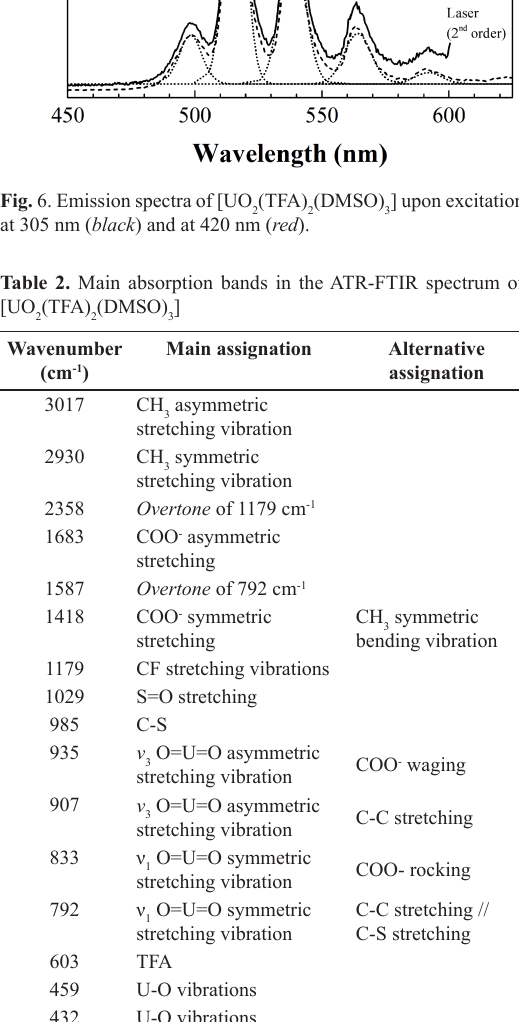
(TFA) (DMSO) ] in a 10 -5 M 2 2 3